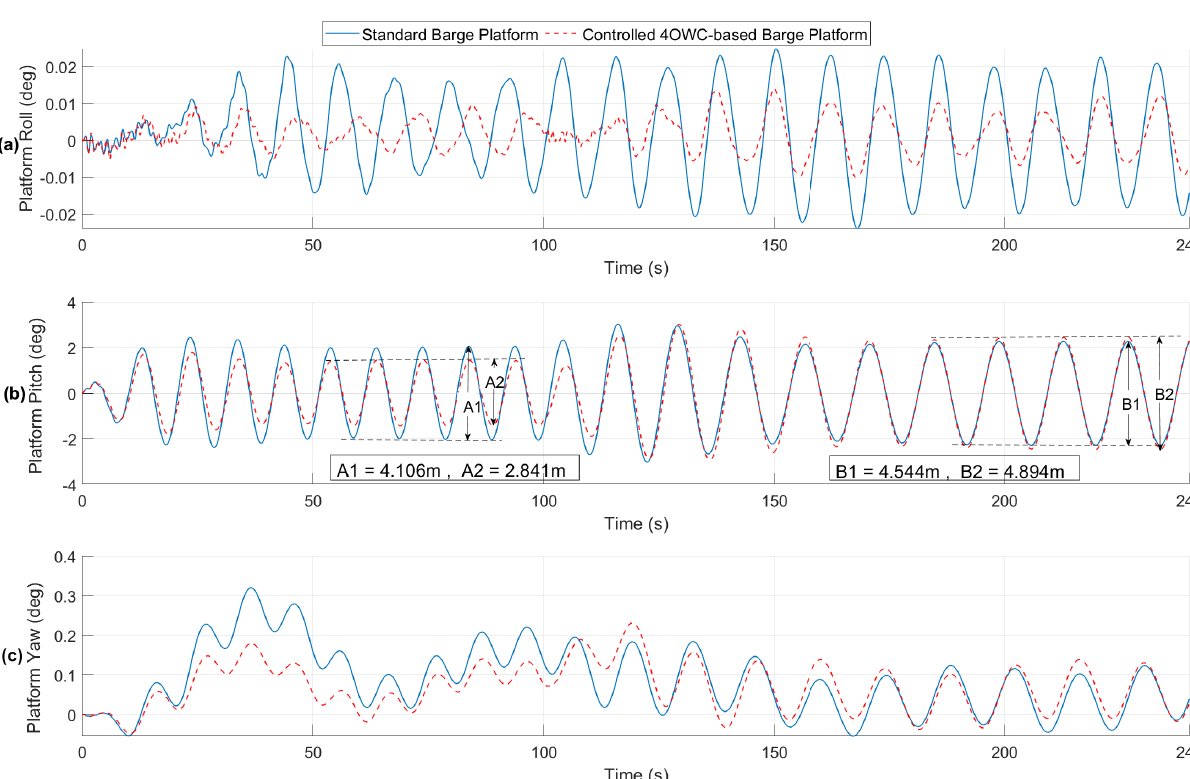
Figure 9. Platforms’ rotational modes. ( a ) Roll. ( b ) Pitch. ( c )